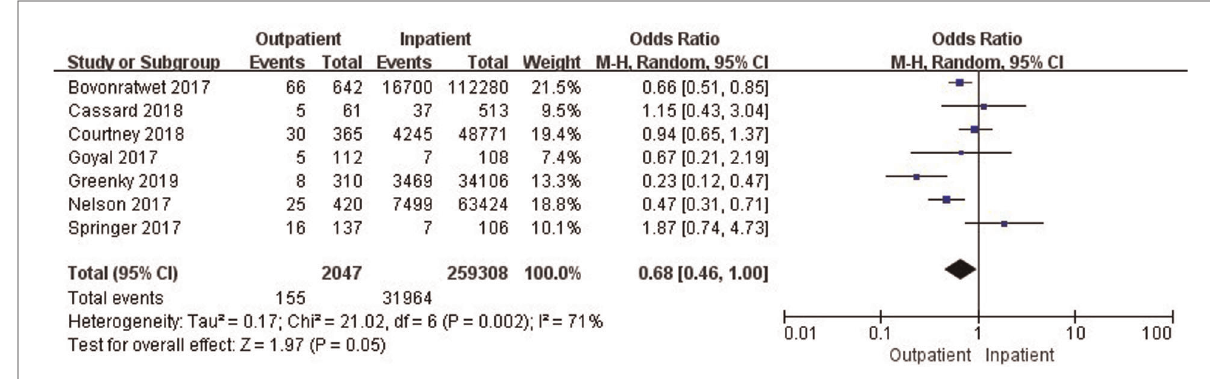
FIGURE 2 Comparison of 30-day total complications between outpatient and inpatient